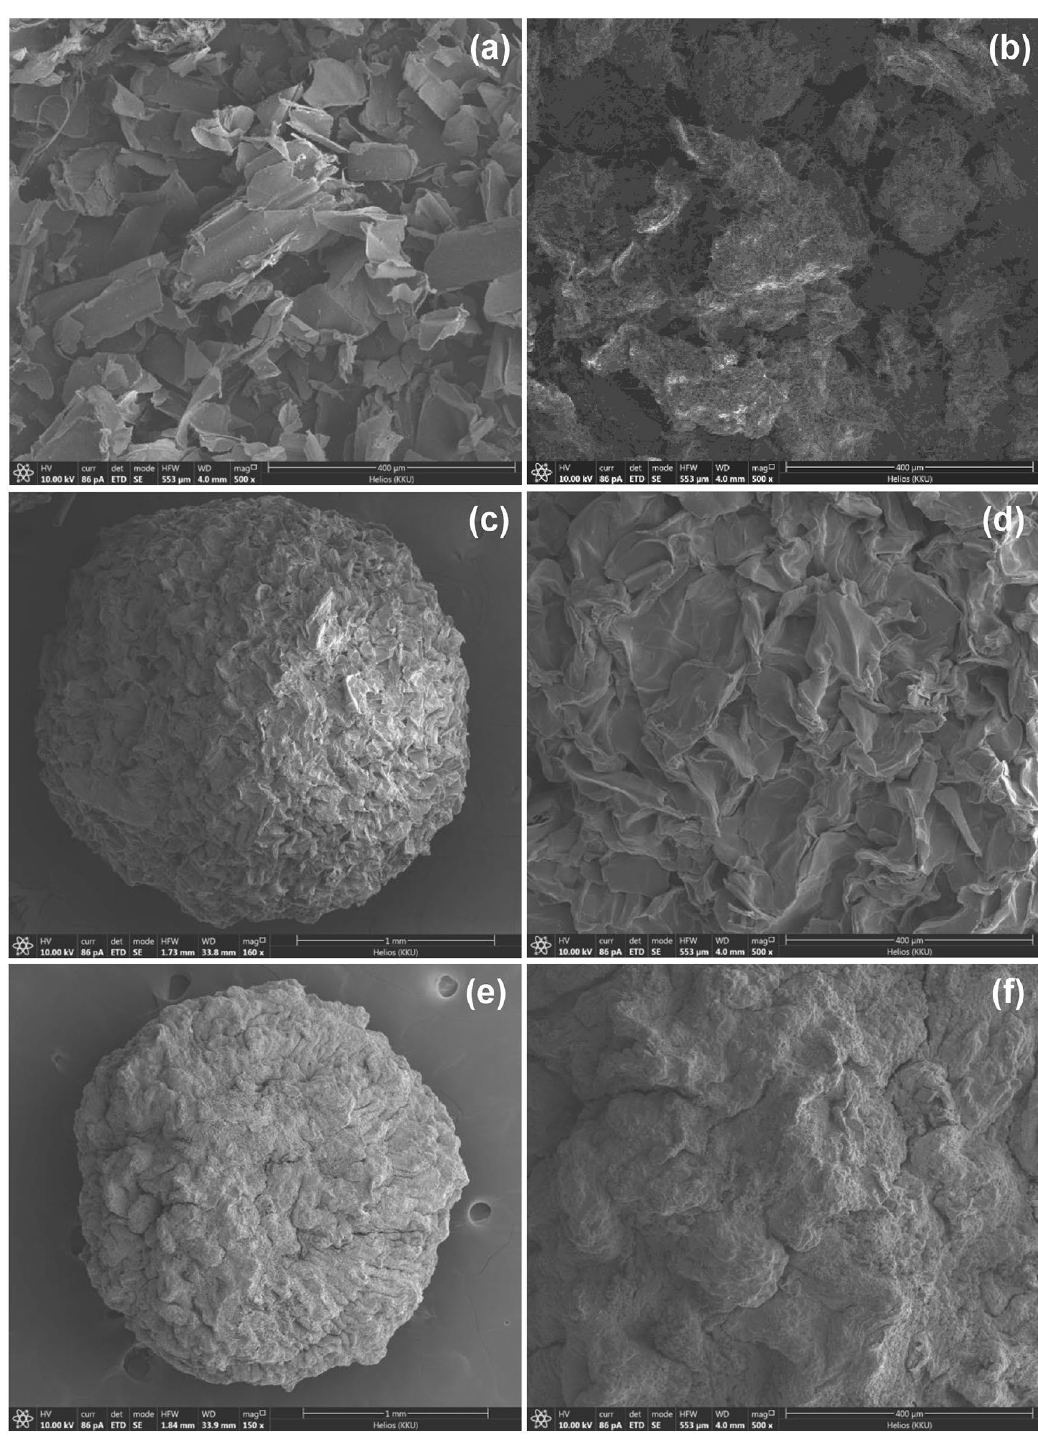
Figure 3. The surface morphologies of ( a ) sugarcane bagasse powder (SB), ( b ) sugarcane bagasse powder doped iron(III) oxide-hydroxide (SBF), ( c , d ) sugarcane bagasse powder beads (SBB) in bead and surface, and (e and f) sugarcane bagasse powder doped iron(III) oxide-hydroxide beads (SBFB) in bead and surface by FESEM- FIB